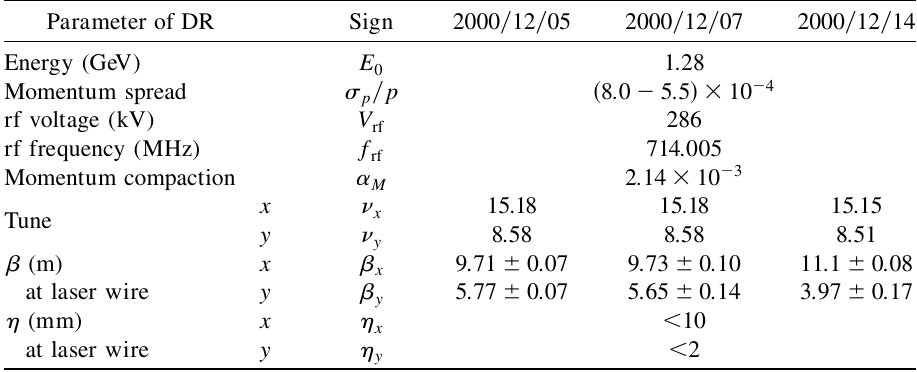
TABLE III. Summary of the parameters of the damping ring (measured